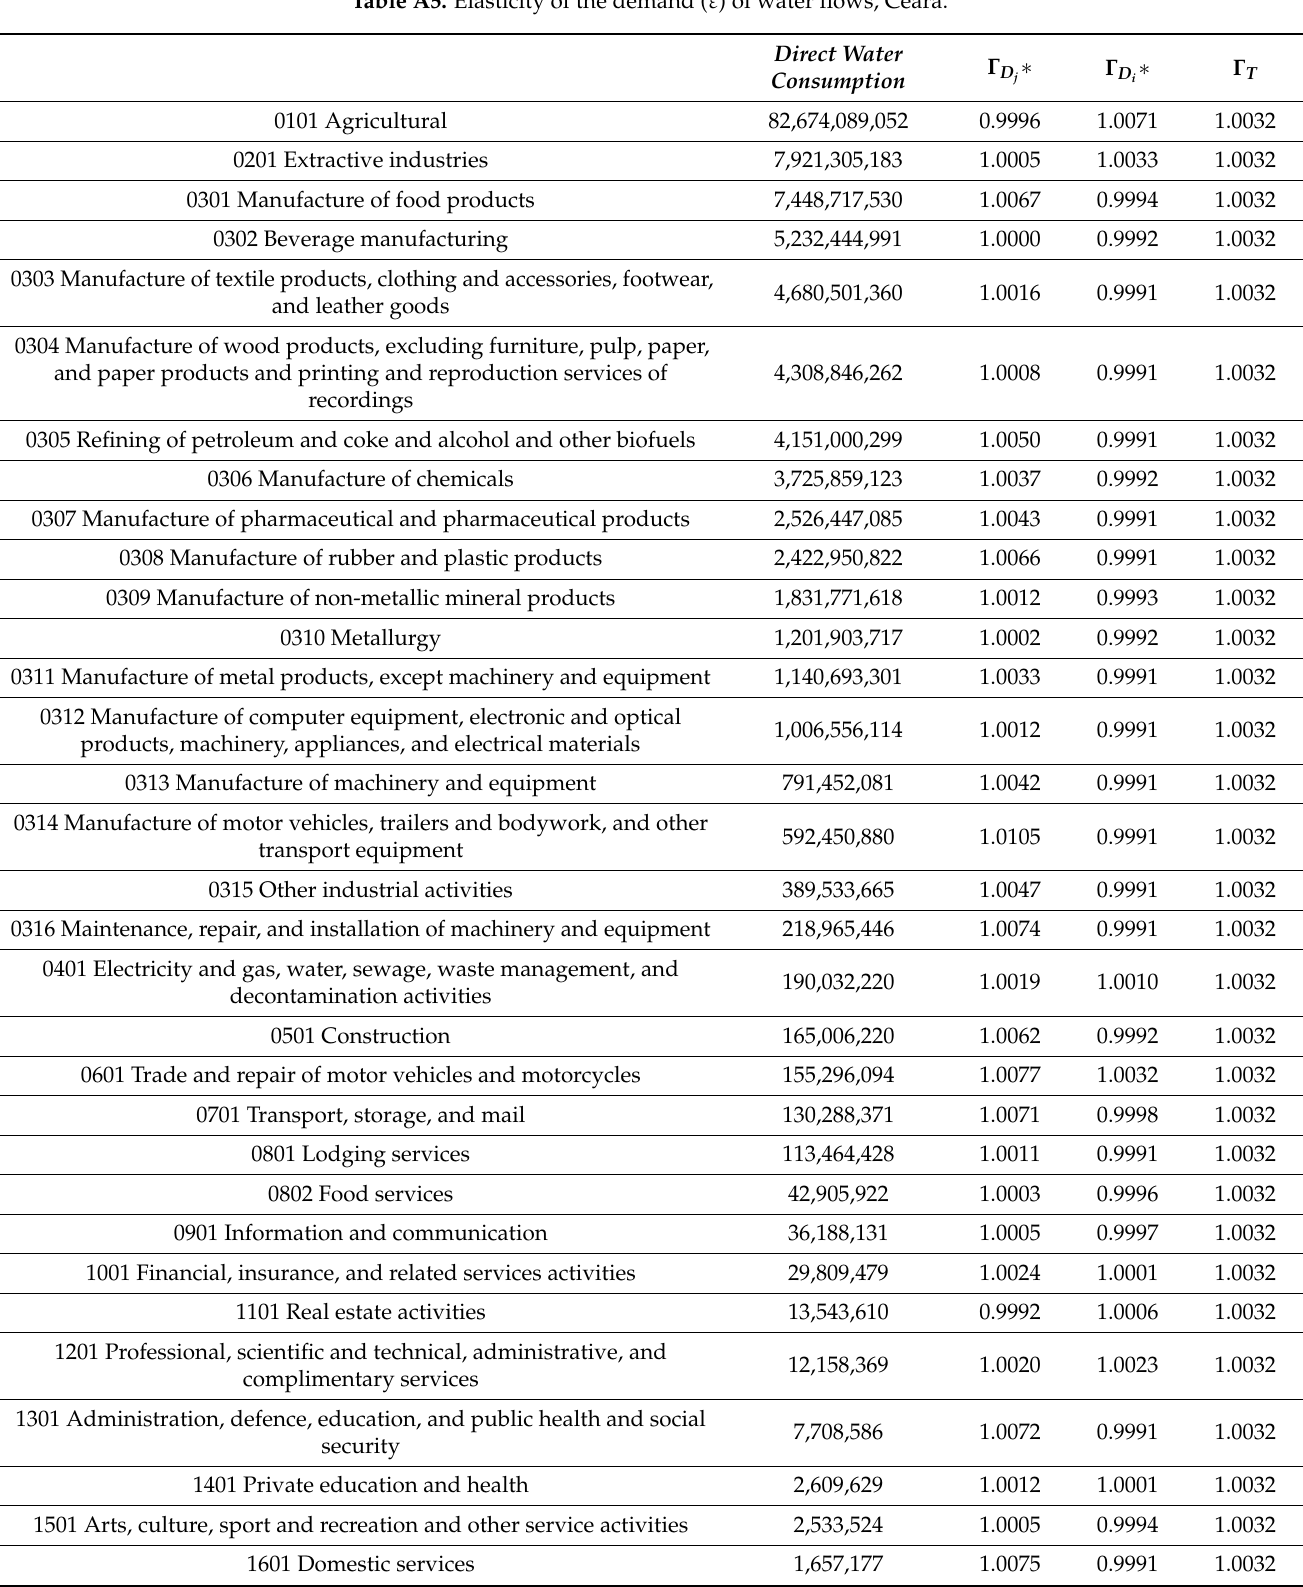
Table A5. Elasticity of the demand ( ε ) of water flows, Cear á .